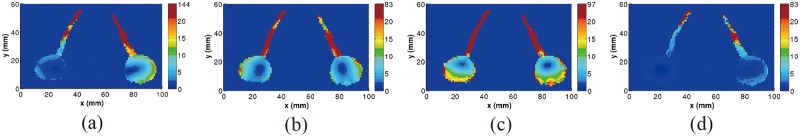
Comparison of the electric field distribution (V/m) in eyeball tissue and optical nerve for double cone coil (a), H-coil (b), HCA coil (c) and Fo8 coil (d).